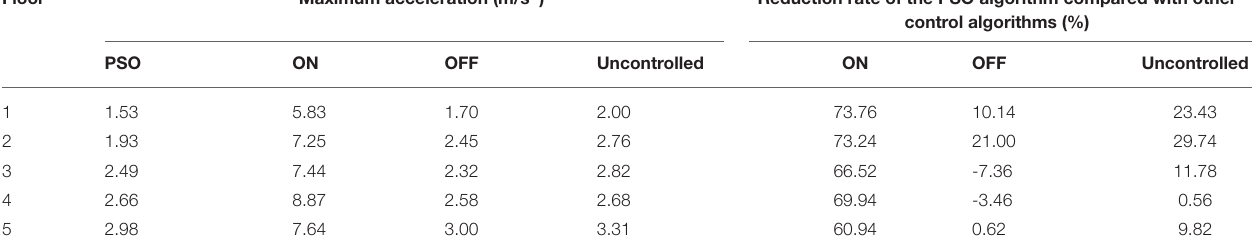
TABLE 4 | The maximum acceleration responses comparison of each floor